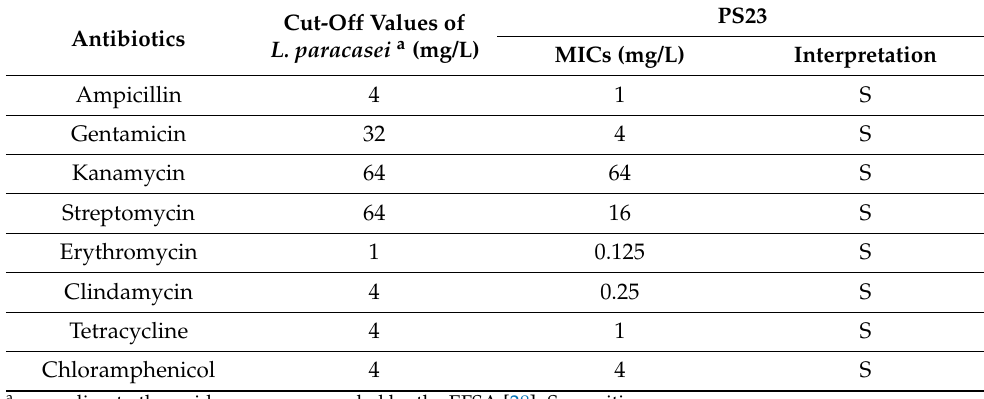
Table 1. Minimum inhibitory concentration (MIC) values of antibiotics to L. paracasei PS23. PS23 Cut-Off Values of Antibiotics L. paracasei a (mg/L) MICs (mg/L) Interpretation Ampicillin